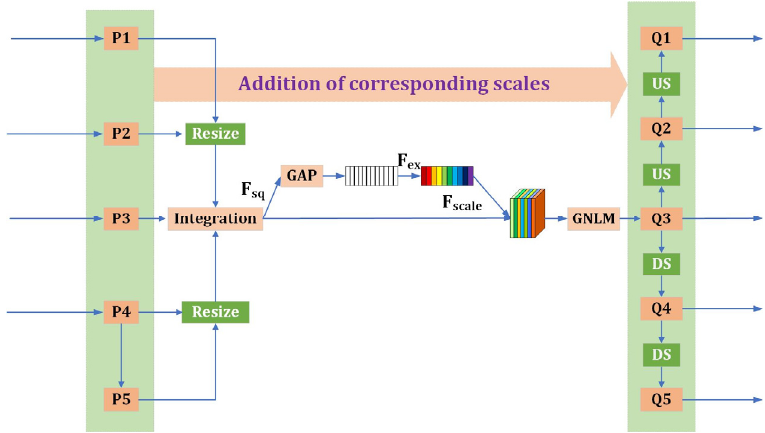
Figure 6. The introduction strategy of attention mechanism.